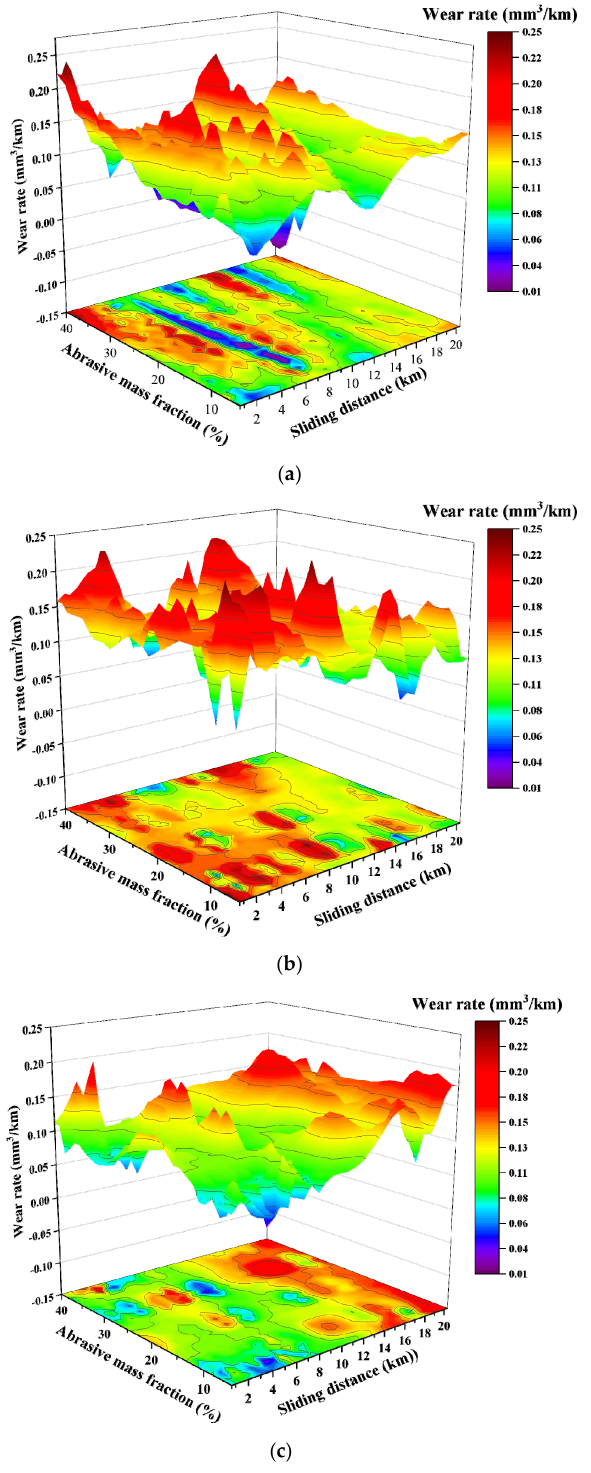
Figure 2. The relationship between the wear rate and sliding distance for the test groups with single soft abrasive: ( a ) talc; ( b ) dolomite; ( c ) fluorite.